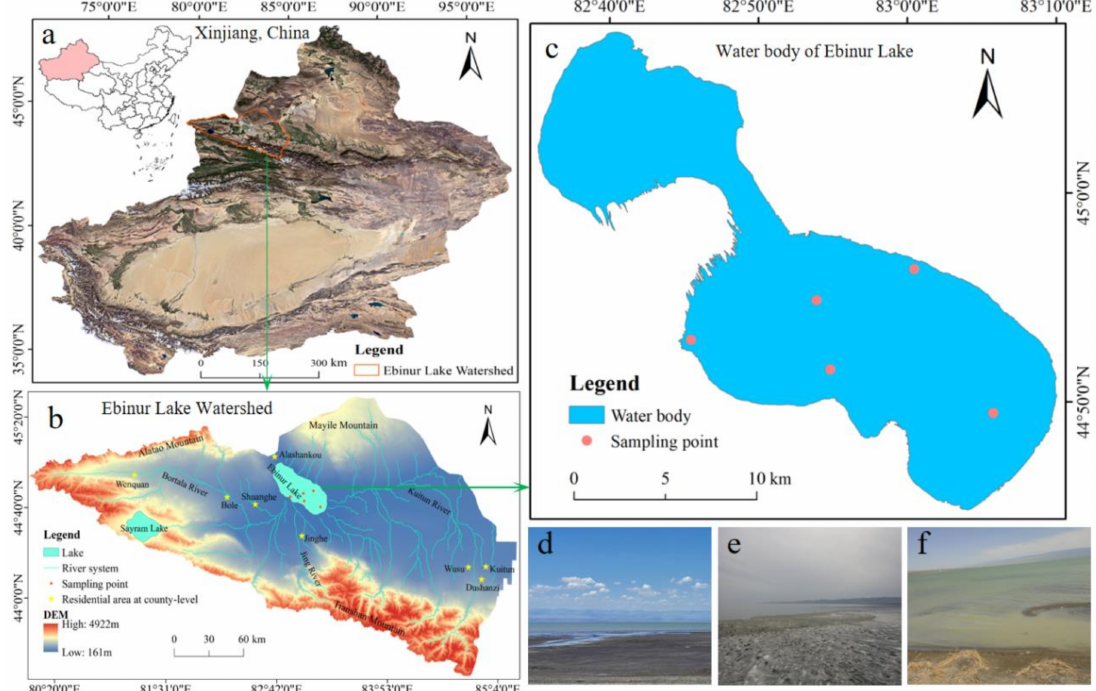
Figure 1. The study area: ( a ) the Xinjiang Uyghur Autonomous Region in northwestern China; ( b ) the Ebinur Lake Watershed with elevation and drainage information; ( c ) the water body and five sampling points at Ebinur lake extracted on 29 August 2017; ( d ) view of Ebinur Lake with sunny weather; ( e ) Ebinur Lake in salt-dust weather; ( f ) the visual effect of Ebinur